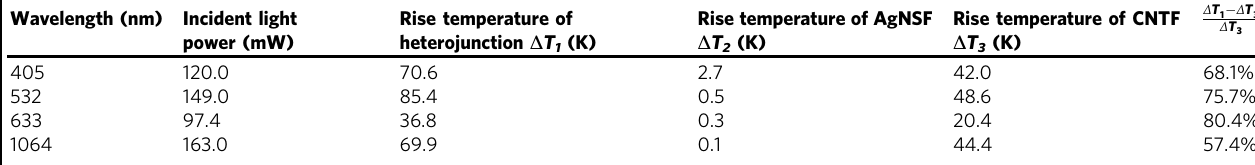
Table 1 Comparison of the photothermal conversion performance of the AgNSF/CNTF heterojunction, AgNSF, and CNTF. Wavelength (nm) Incident light power